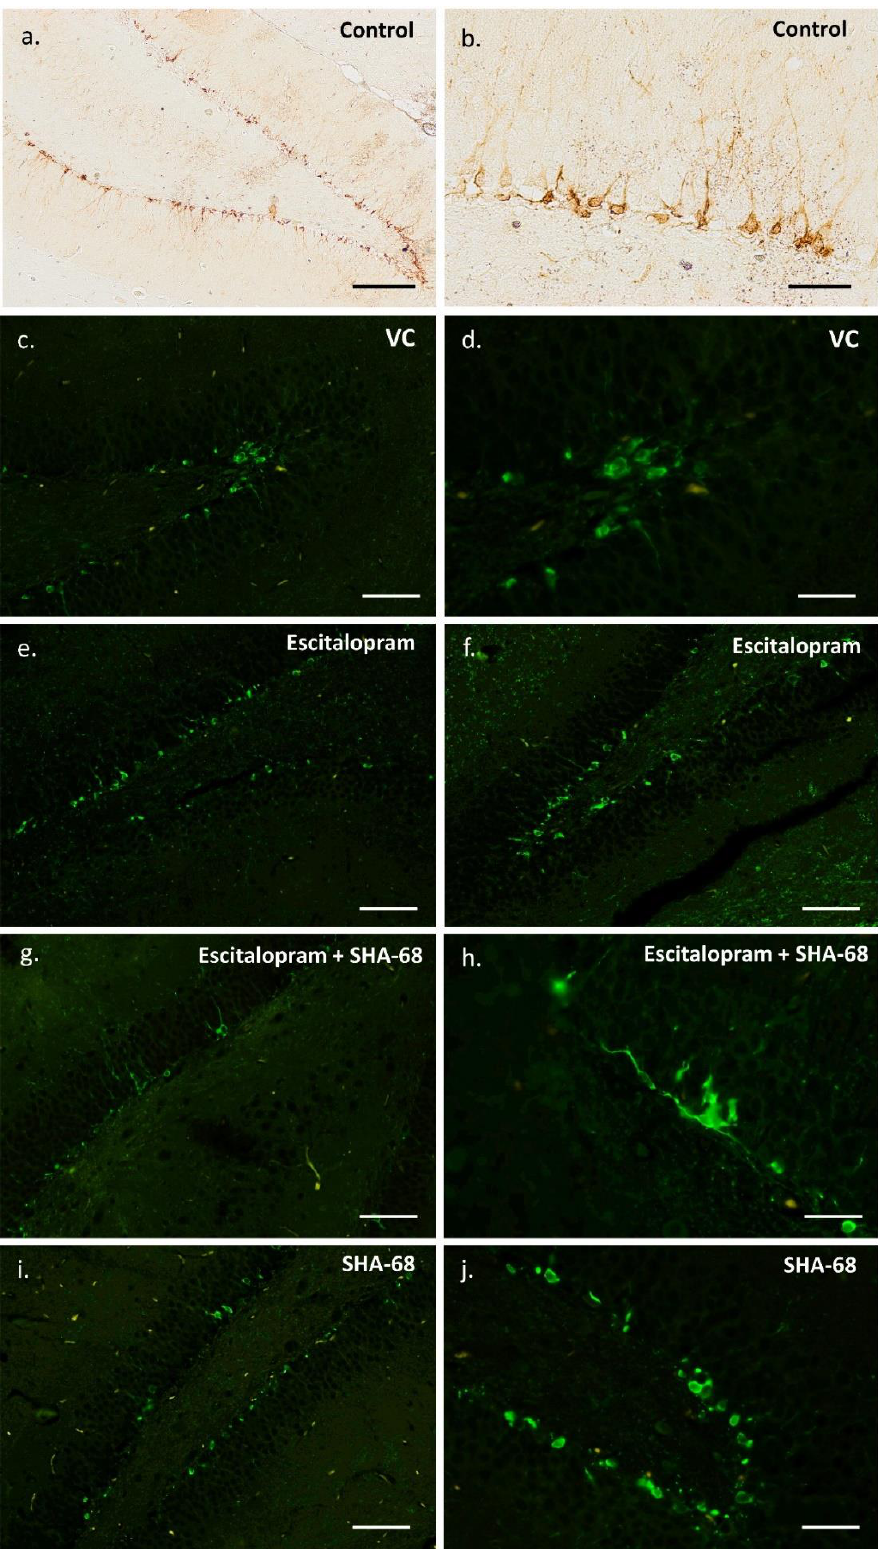
Figure 2. DCX-expressing immature neurons in the neurogenic subgranular zone (SGZ) of control rats ( a , b ) and animals after treatment with: escitalopram ( e , f ), escitalopram + SHA68 ( g , h ), SHA-68 ( i , j ) and vehiculum (SHA-68 solvent; ( c , d )). Scale bars: 50 µ m ( b , d , h , j ), 100 µ m ( a , c , e – g , i ). Fluorescence, secondary antibody coupled with FITC. Images captured with Nikon Eclipse Ti microscope.